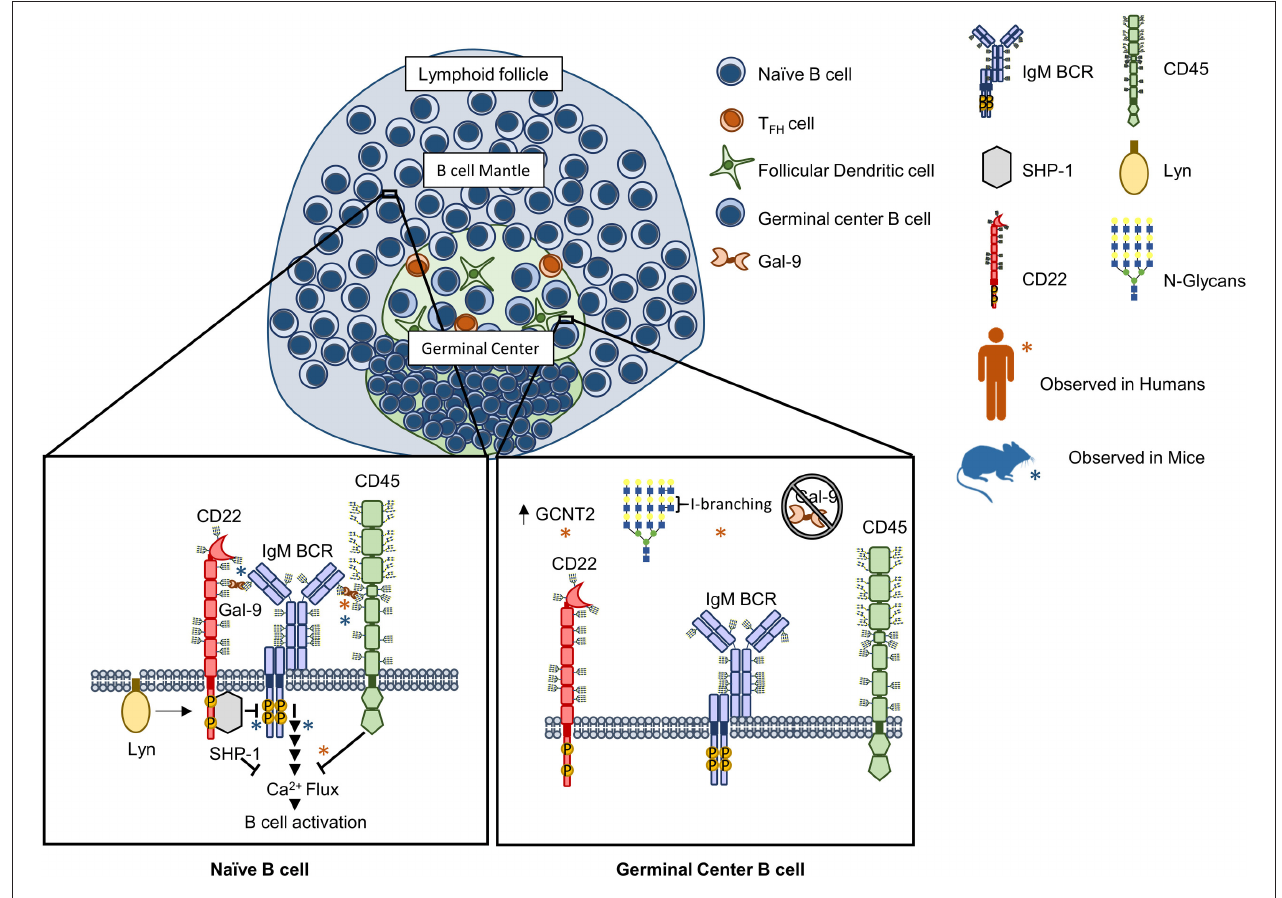
FIGURE 1 | Galectin-9 regulates B cell receptor signaling in human and murine B cells through analogous but distinct mechanisms . Naïve B cell activation is antagonized by Gal-9 through binding to the receptor tyrosine phosphatase CD45 on human B cells that activates a Lyn-CD22-SHP-1 dependent circuit and inhibits calcium accumulation downstream of the BCR [Left, orange asterisks (*)]. In murine B cells, Gal-9 similarly regulates BCR signaling by altering the nanoscale organization of signaling molecules. Specifically, Gal-9 has been found to bind CD45 but also IgM BCR, preventing exclusion of CD45 and CD22 upon B cell activation and leading to impaired signal transduction following BCR ligation [Left, blue asterisks (*)]. In humans, Gal-9 binding activity is differentially regulated between naïve and germinal center (GC) B cells via concerted alterations in N-glycosylation. Specifically, Gal-9 binding has been shown to be greatly diminished in germinal center (GC) B cells via upregulation of the glycosyltransferase GCNT2, which catalyzes I-branch formation on glycan ligands of Gal-9 (poly-LacNAcs), and attenuates Gal-9 binding (56,